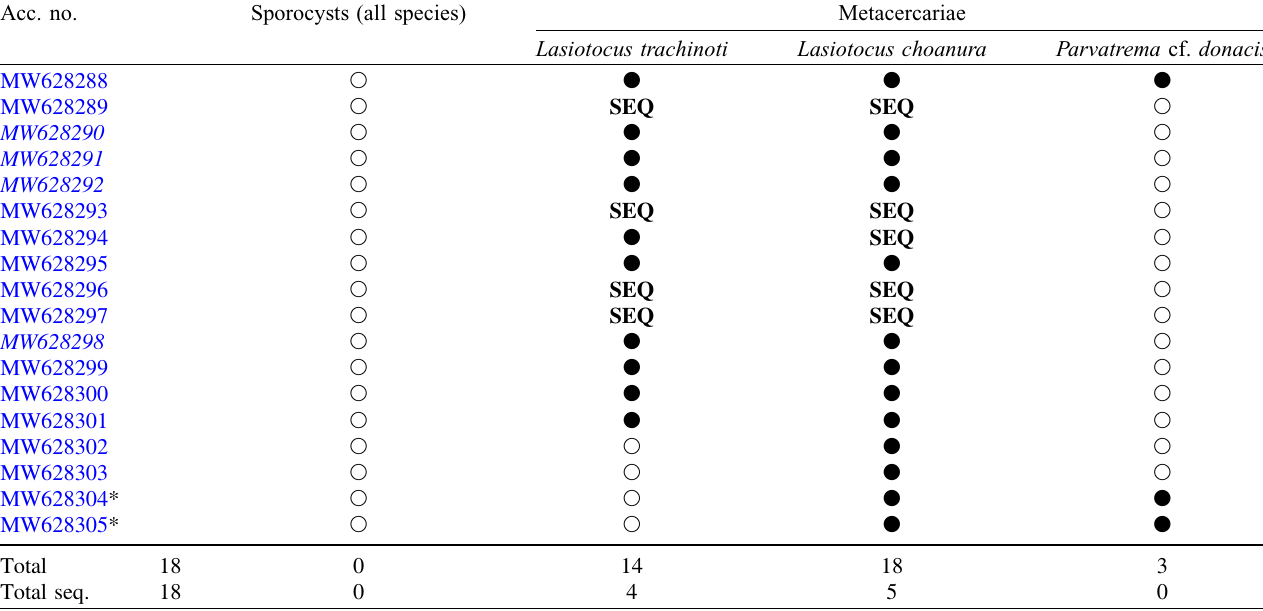
Table 3. GenBank accession numbers (acc. no.) of cytochrome c oxidase I mitochondrial DNA sequences from individuals of Donax variabilis infected by metacercariae of Lasiotocus trachinoti , L. choanura , and Parvatrema cf. donacis collected from South Carolina, USA from June through October between 2018 and 2020 (except for two individuals (*) that were collected in 2010 and not included in prevalence data). No individual was infected with